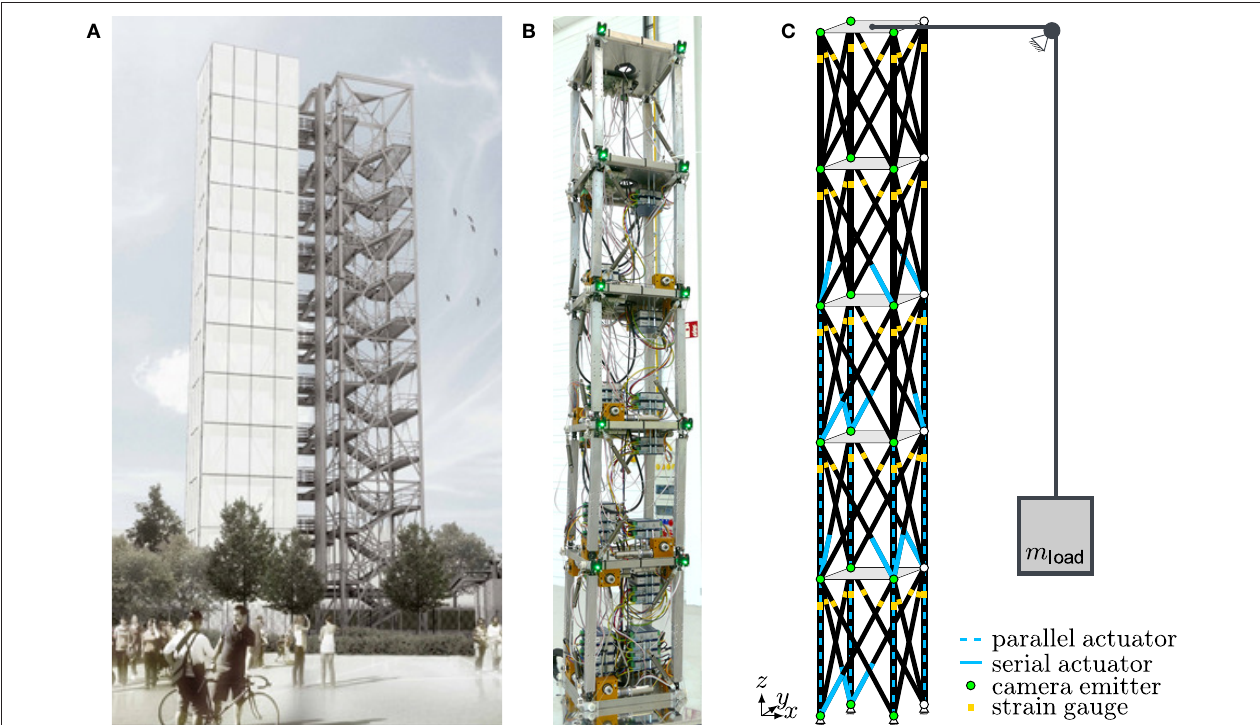
FIGURE 2 | (A) Rendering of the full-size adaptive high-rise structure (left) and the access tower (right) ( © ILEK), (B) picture of the 1:18 scale model, and (C) sketch of the scale model with actuator and sensor equipment and load mounting.